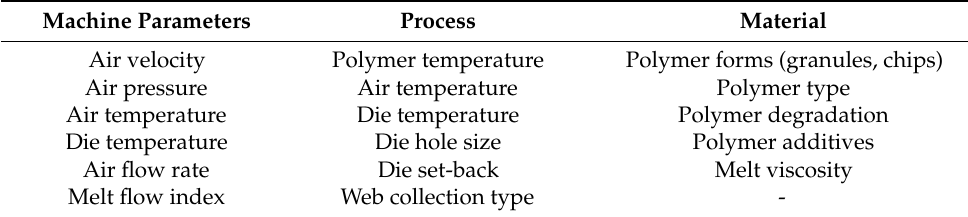
Table 4. Definition of machine, process, and material parameters [31,34–37].